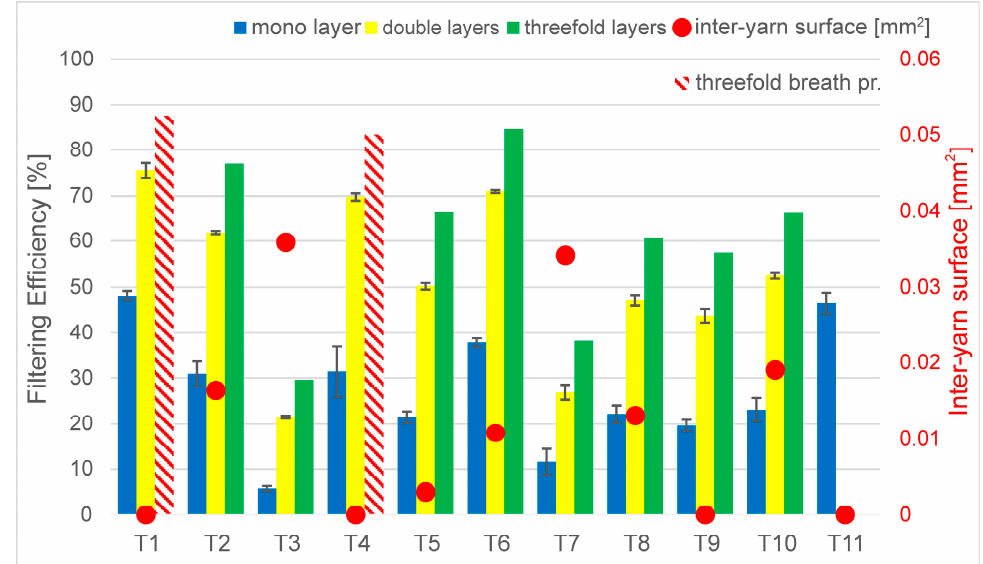
Figure 5. Filtration efficiency versus inter-yarn surfaces.